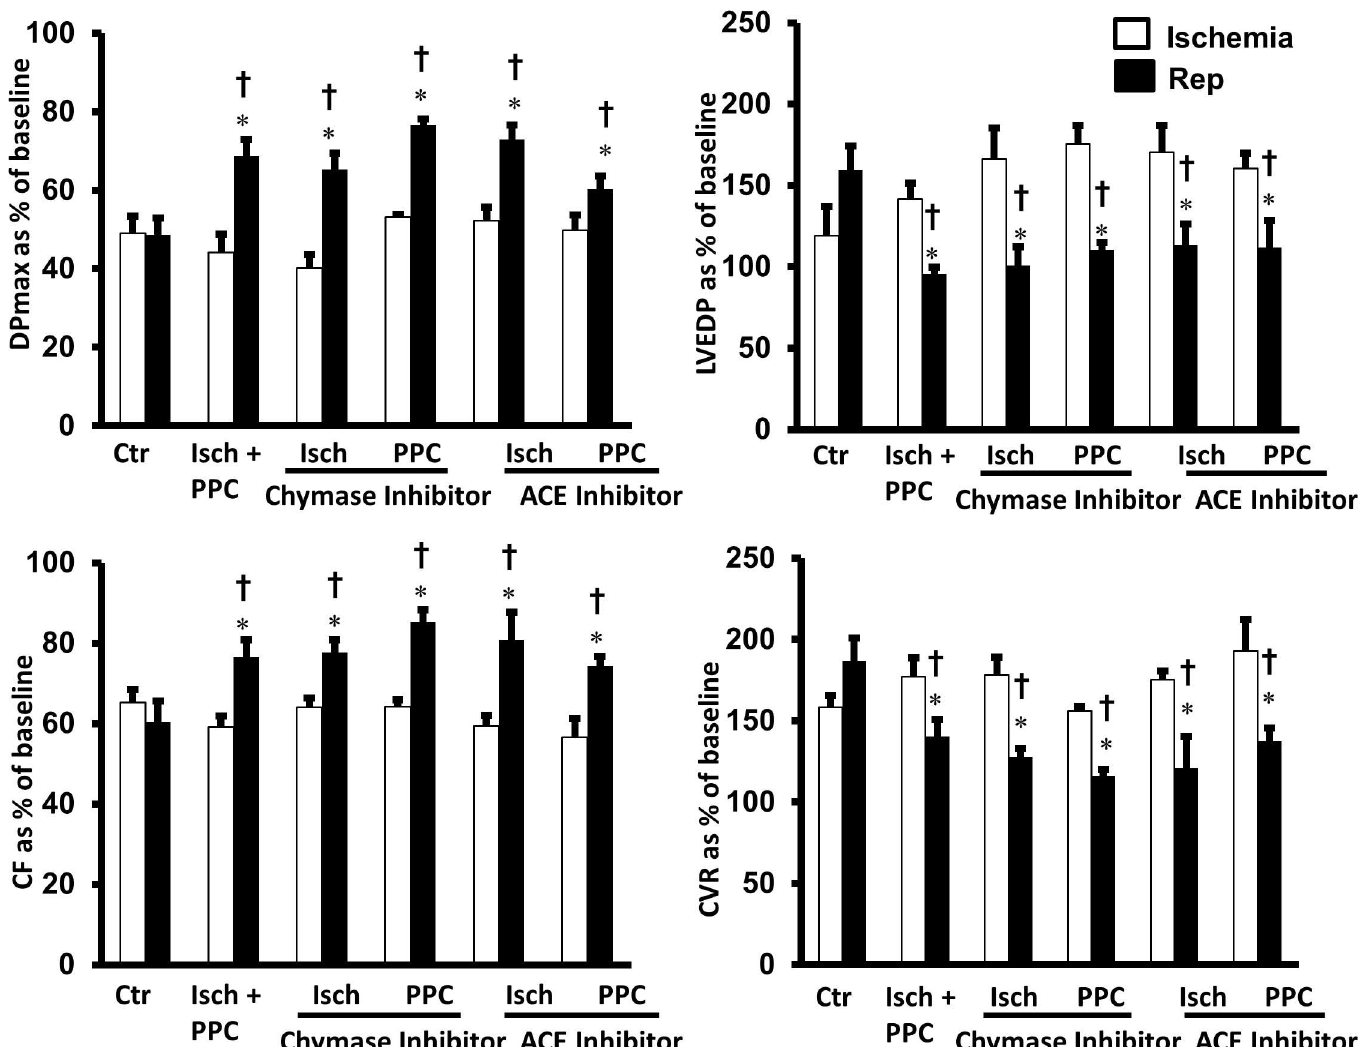
Fig 4. The role endogenously produced Ang II in PPC mediated cardiac protection. Isolated rat hearts (n = 8 per group) were subjectedto I/R injury and PPC in the presence or absence of ACE inhibitor(captopril, 100 μ M) or chymase inhibitor (chymostatin, 100nM). Post-ischemic recovery of cardiac functions were recorded. (A) DPmax, (B) LVEDP, (C) CF and (D) CVR. The data were computed at 30 min reperfusionand are expressed as means ± SEM. DPmax, maximum developedpressure; LVEDP, left ventricular end diastolic pressure; CF, coronary flow; CVR, coronary vascular resistance; Ctr, control; Isch, ischemia; PPC, pacing postconditioning. * P < 0.05 compared to respective control, † P < 0.05 compared to ischemic